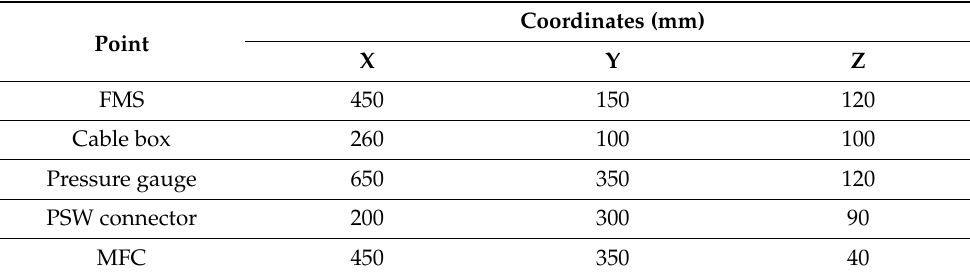
Figure 5. Monitoring points (FMS, cable box, pressure gauge connector, PSW connector, MFC). Table 4. Monitoring points.